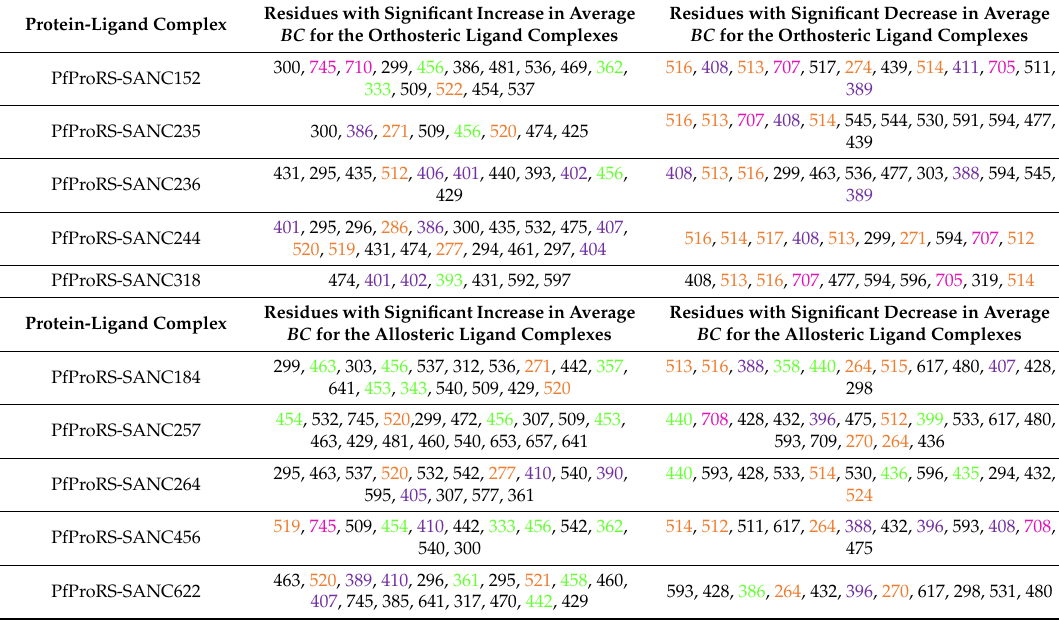
Table 3. Residues with significant changes in average BC (2 standard deviations away). Residues at the active site are shown in green, residues at the ATP binding site in purple and residues at the Z-domain in magenta. Protein-Ligand